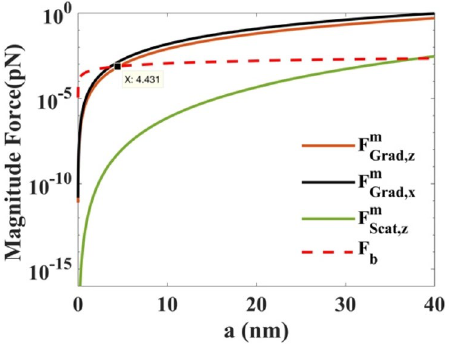
Figure 7. Comparison of F m Grad , z , F m Scat , x , F m Grad , x , and F b versus the radius a on high-index ( n p = 1.592 ) particles. Other parameters are (cid:31) = 1.064 µ m , w 0 = 5 mm , f = 5 mm , P = 4 w , the distance δz = 0 from the focus point, and the constant g = 1